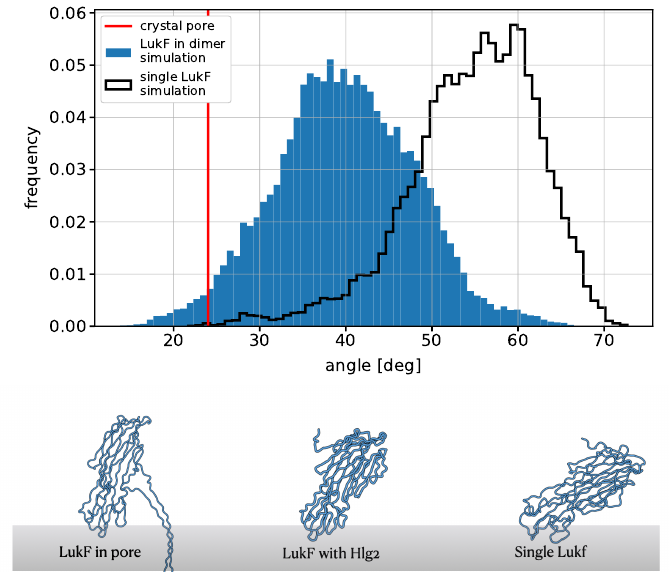
Figure 4. Distribution of the angle between LukF and the axis perpendicular to the membrane. The filled blue histogram refers to the simulation of spontaneous dimerization, while the black empty histogram refers to the simulation of the LukF monomer alone on the membrane. The red dashed line corresponds to the angle formed by the LukF protomer in the crystal structure of the assembled pore (PDB ID: 3B07). The images of the LukF monomer show the differences in LukF orientation between the three stages of pore